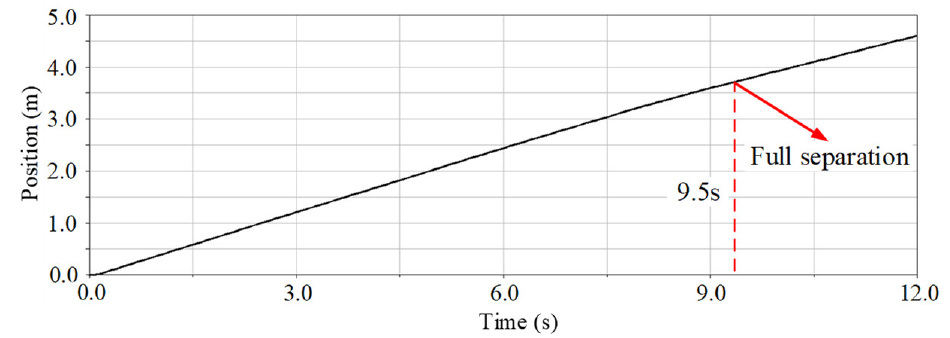
Figure 12. Variation of displacement versus time.